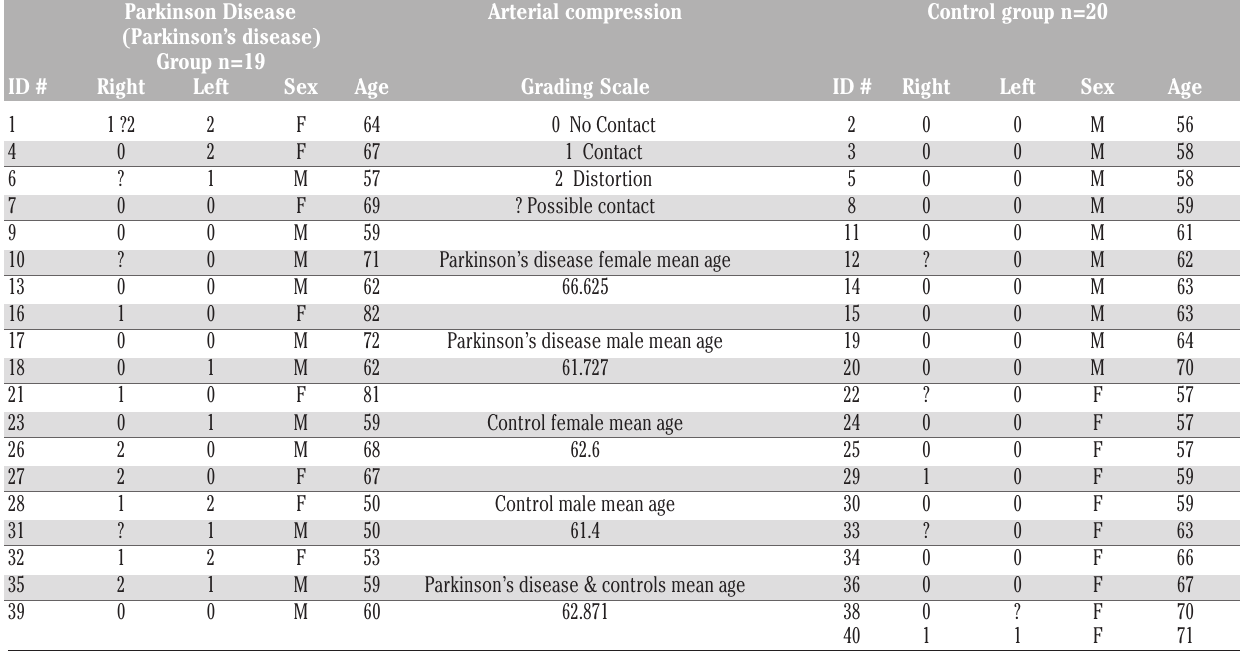
Table 1. Parkinson disease: compression of cerebral peduncle by posterior cerebral artery. Parkinson Disease Arterial compression Control group n=20 (Parkinson’s disease)